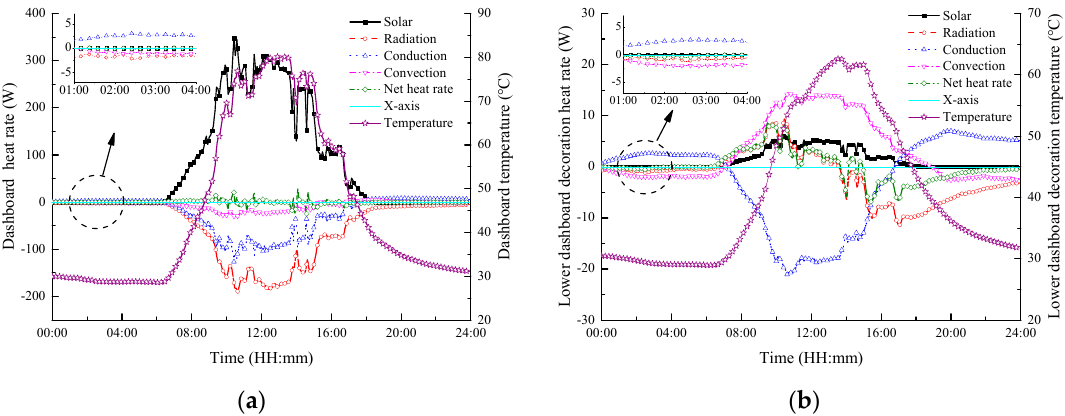
Figure 11. Diurnal variation rules on weathering external factors and heat transfer of different types of parts: ( a ) Type I part (dashboard); and ( b ) Type II part (lower dashboard decoration). Table 5. Diurnal temperature difference for different types of parts.